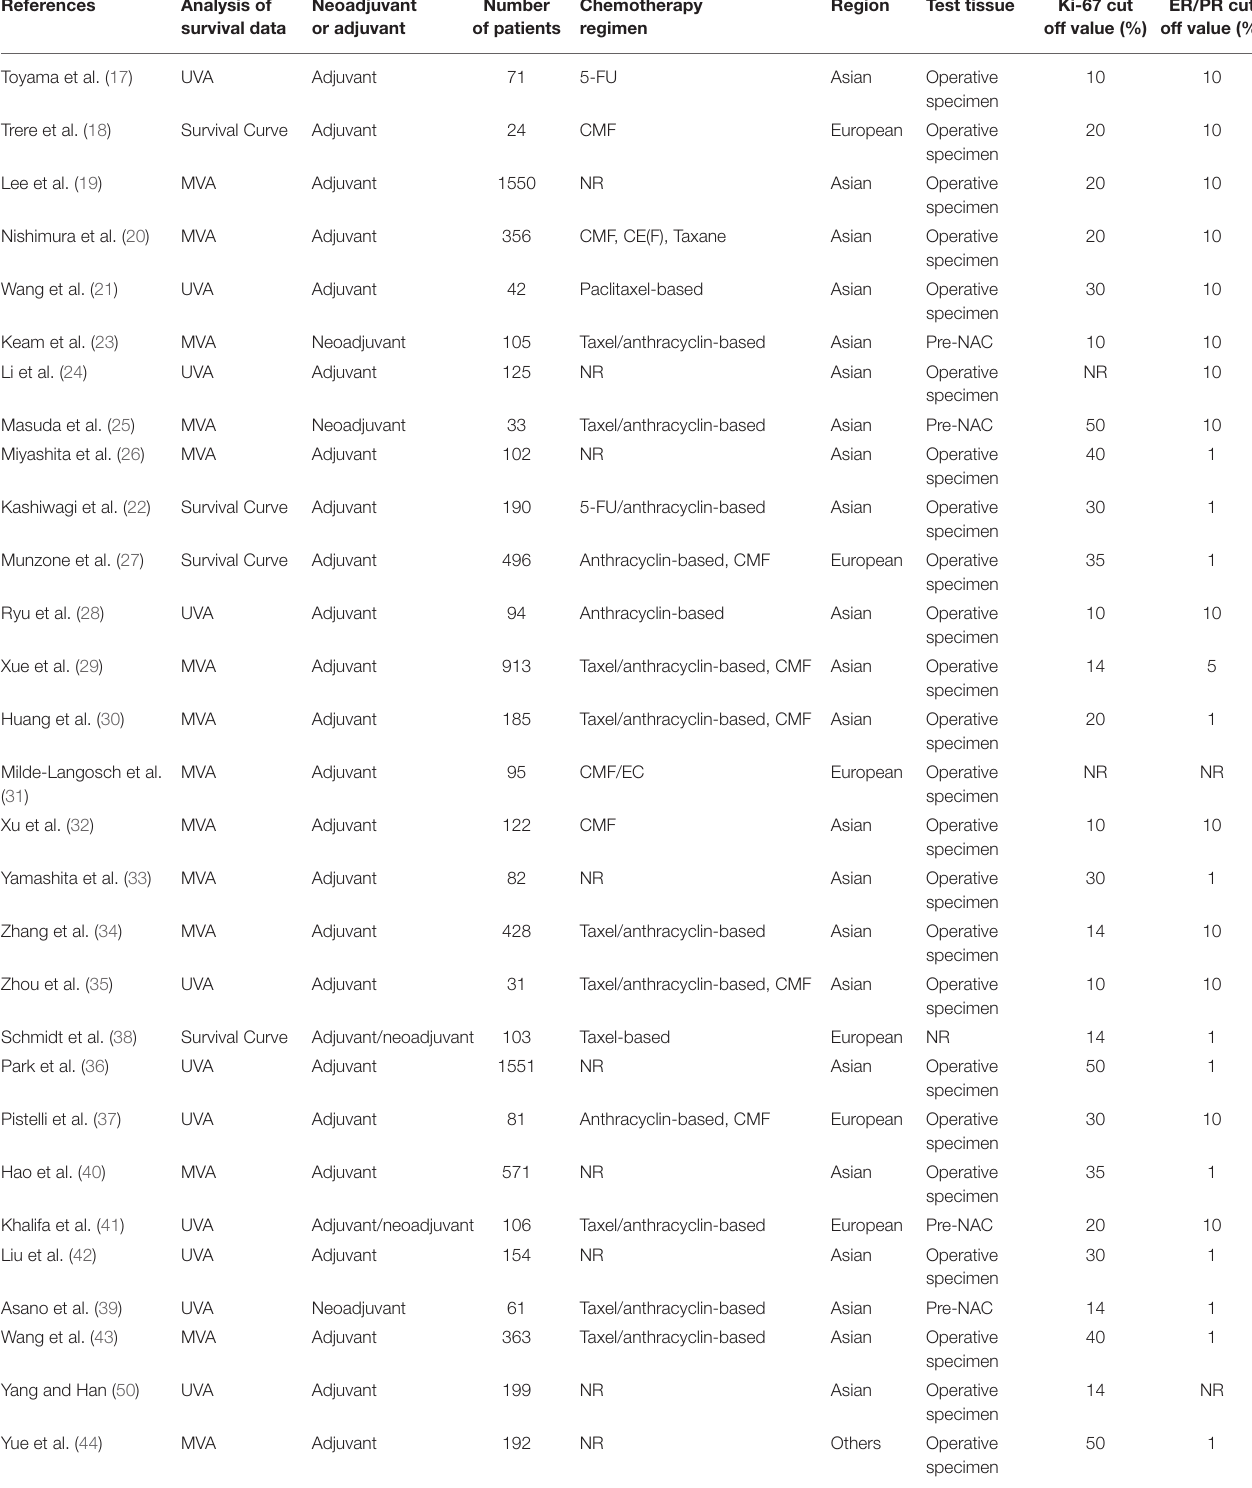
TABLE 1 | Characteristics of the included studies in this